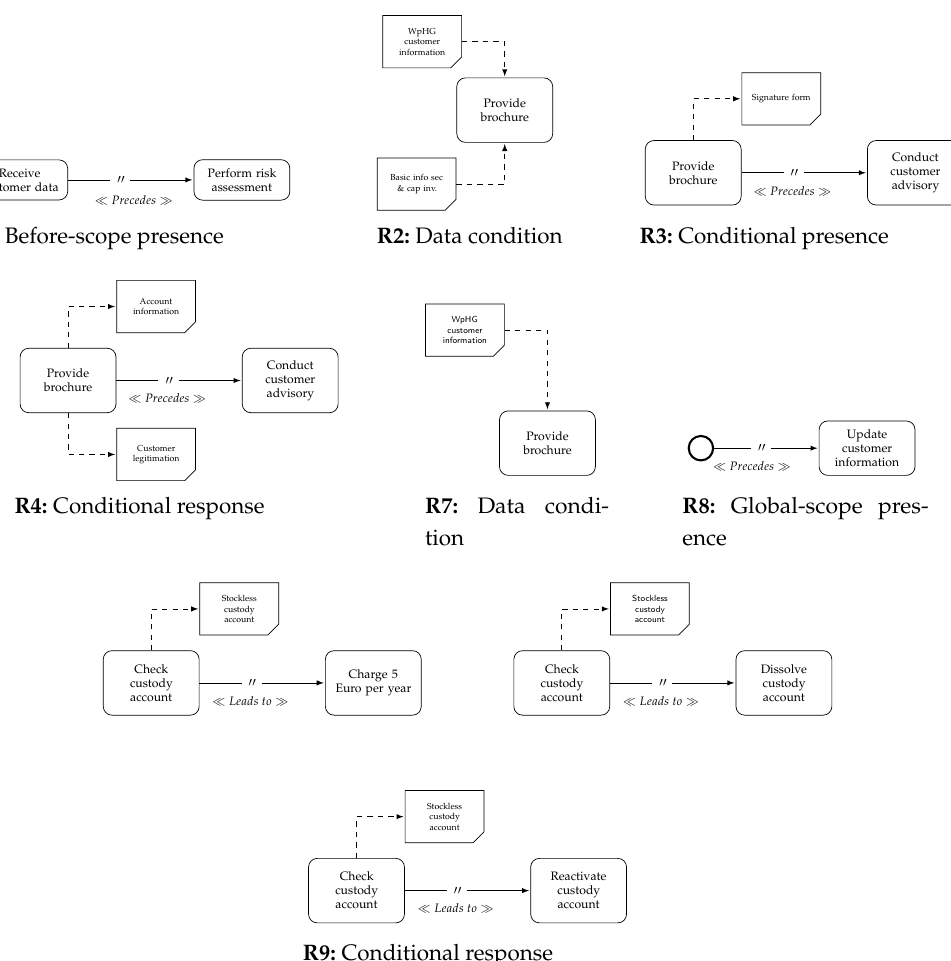
Figure 4. Formalised requirements in BPMN-Q